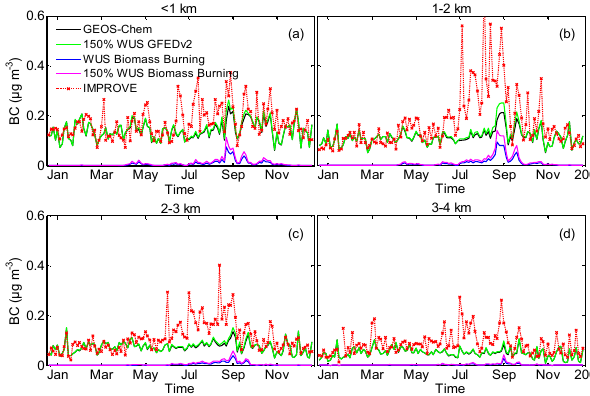
Figure 10 . (a-d) Same as Figure 4, but from simulations with standard 8-day Fig. 10. (a–d) Same as Fig. 4, but from simulations with stan- GFEDv2 emissions (black line) and with 8-day GFEDv2 emissions increased by 50% (green line) over the WUS. Also shown are contributions to surface BC dard GFEDv2 8-day emissions (black line) and with GFEDv2 8- from biomass burning emissions (blue line) and 150% biomass burning emis- day emissions increased by 50% (green line) over the WUS. Also sions (pink line) over the WUS . shown are contributions to surface BC from biomass burning emis- sions (blue line) and 150% biomass burning emissions (pink line) over the WUS